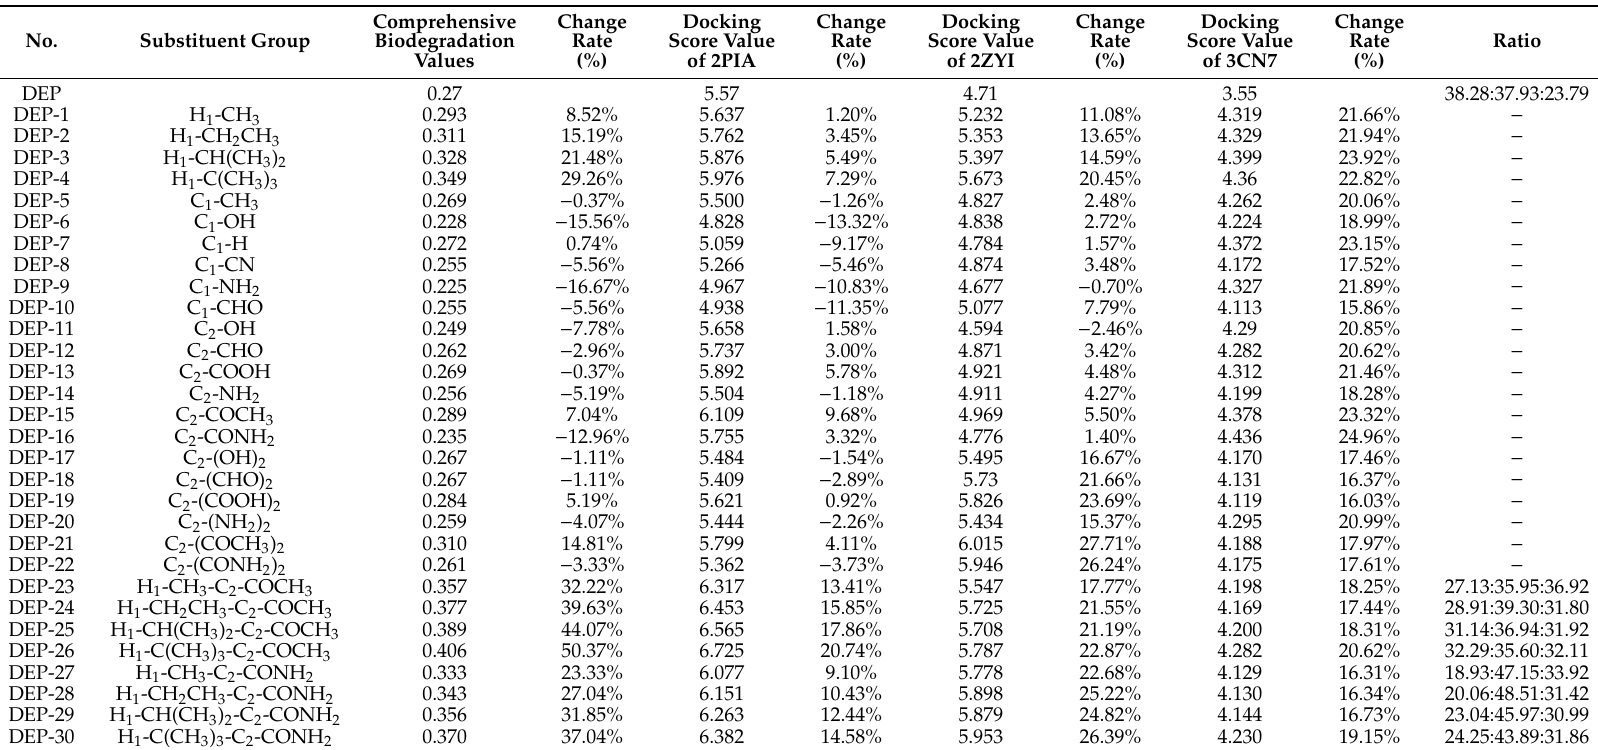
Table 3. Prediction of the CoMSIA model of comprehensive and the single biodegradability of DEP derivatives and their change